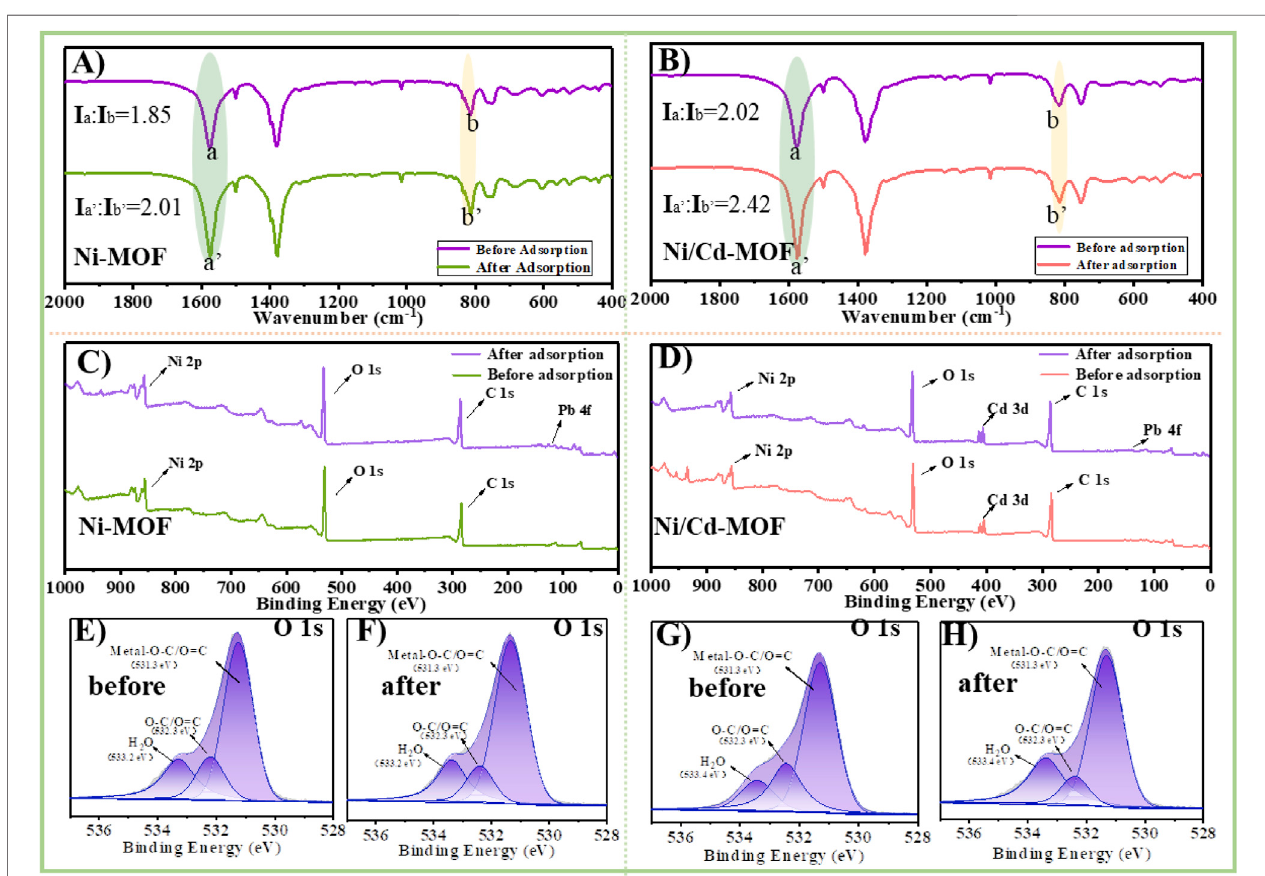
FIGURE9 | FTIR spectra of (A) Ni-MOF and (B) Ni/Cd-MOFbeforeand after Pb 2+ adsorption. XPS fullspectraof (C) Ni-MOF and (D) Ni/Cd-MOF before and after Pb 2+ adsorption. High-resolution XPS O1 spectra (E) before and (F) after Pb 2+ adsorption on Ni-MOF. High-resolution XPS O1 spectra (G) before and (H) after Pb 2+ adsorption on